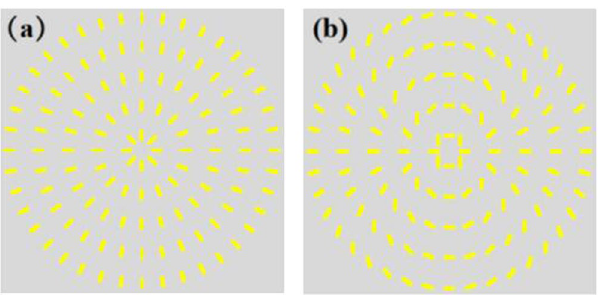
Figure 2. The optical axis distributions of the metasurfaces. Theoretical optical axis distributions of the metasurface ( a ) q = 1, ( b ) q =